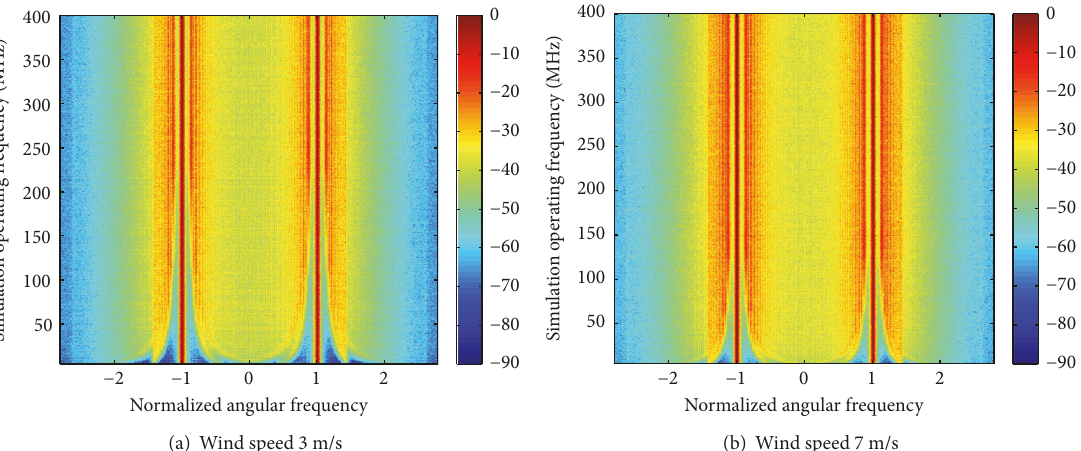
Figure 9: Numerical simulated Doppler spectrum of linear waves over operating frequency. The horizontal axis is the Doppler angular frequency normalized by the Bragg frequency, and the vertical axis represents different simulation operating frequencies from 5 MHz to 400 MHz.